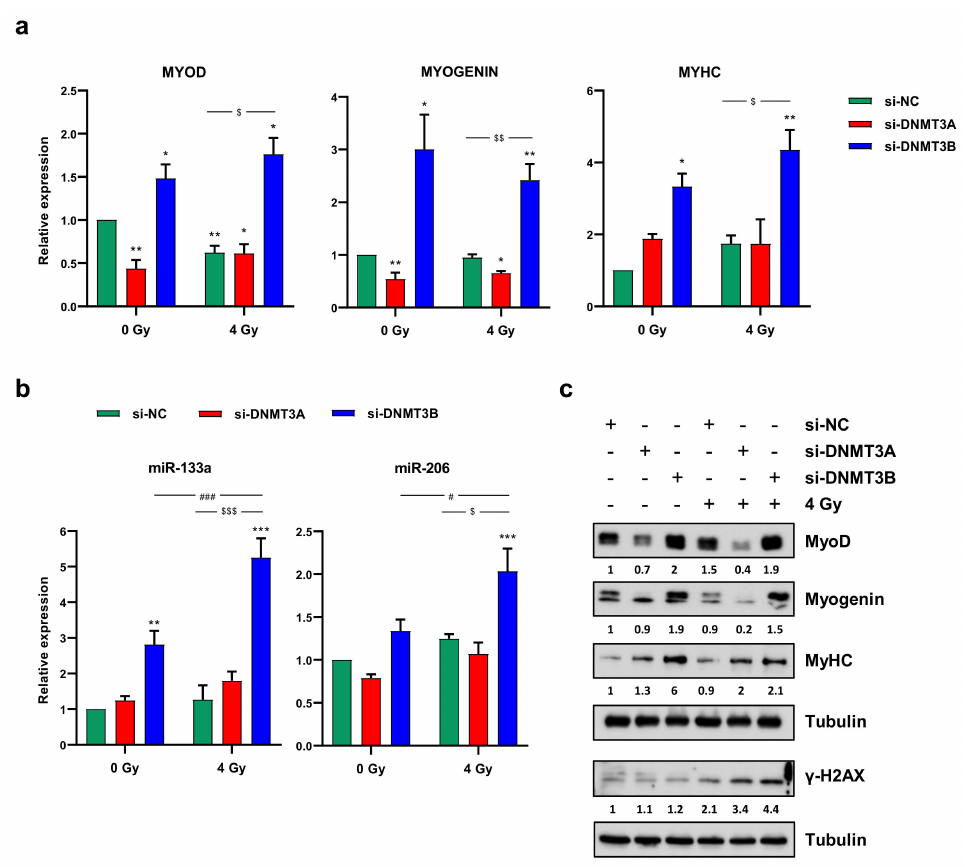
Figure 8. Radiotherapy maintains the myogenic program induced by DNMT3B knocking down. ( a ) Quantitative analysis of differentiation marker MYOD, MYOGENIN and MYHC in RD cells transfected with si-DNMT3A or si-DNMT3B and then exposed to 4 Gy. Data were expressed as fold increase over si-NC/0 Gy, arbitrarily set at 1 and GAPDH was used as endogenous control. Bars represent mean values ± SD of three independent experiments, each performed in triplicate. Statistical analyses were performed by using two-way ANOVA: **, p < 0.01; *, p < 0.05 vs. si-NC/0 Gy; $$, p < 0.01, $, p < 0.05 vs. si-NC/4 Gy. ( b ) q-PCR assay of myomiR miR-133a and miR-206 in RD cells at 144 h after transfection with si-DNMT3A or si-DNMT3B and 96 h after radiation treatment. Data were expressed as fold increase over si-NC/0 Gy, arbitrarily set at 1. U6 was used as internal control. Bars represent means ± SD of five independent experiments, each performed in triplicate. Statistical analyses were performed by using two-way ANOVA: ***, p < 0.001; **, p < 0.01 vs. si-NC/0 Gy; ###, p < 0.001, #, p < 0.05 vs. si-DNMT3B/0 Gy; $$$, p < 0.001, $, p < 0.05 vs. si-NC/4 Gy. ( c ) Western blotting assay showing MyoD, Myogenin, MyHC and γ -H2AX up-regulation in RD cells transfected with si-DNMT3B (144 h) and exposed to IR (96 h). Tubulin expression was used as loading